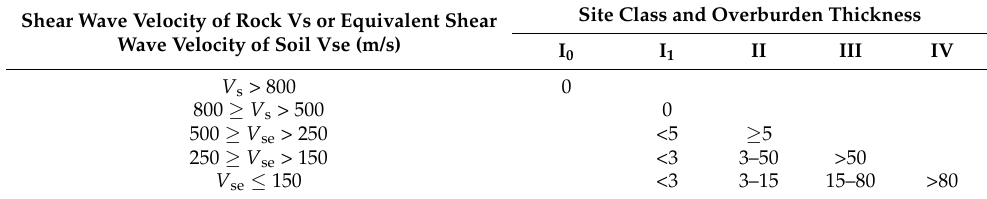
Table 1. Chinese code for classification of